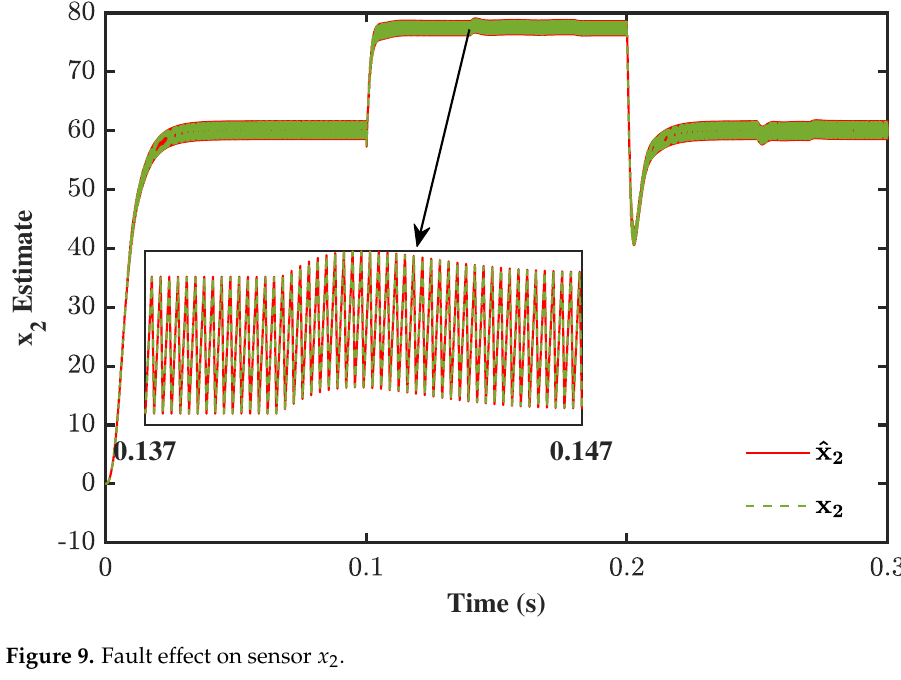
Figure 9. Fault effect on sensor x 2 .